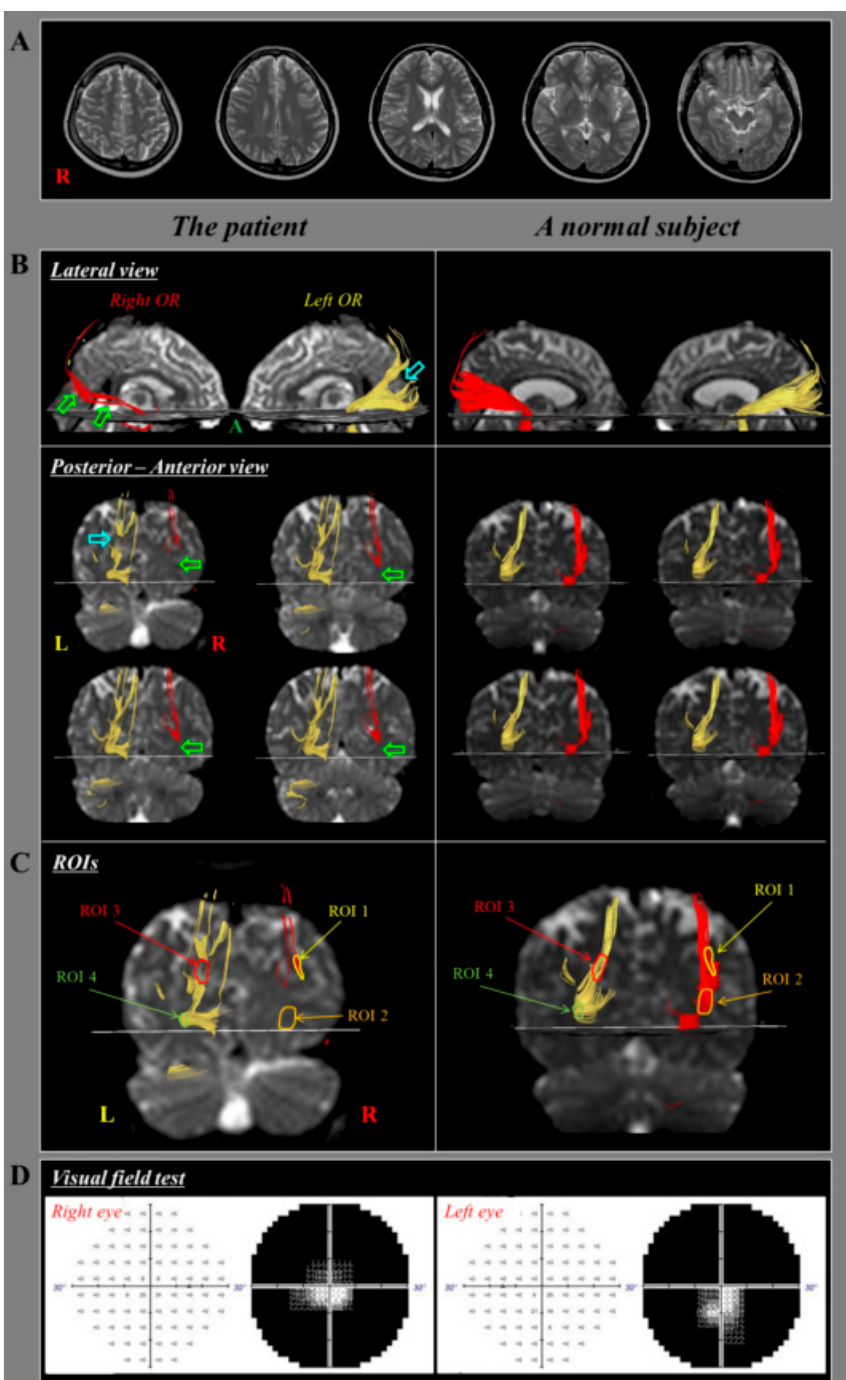
Figure 5. ( A ) Brain magnetic resonance images indicate no specific lesion; ( B ) Diffusion tensor tractography for the bilateral optic radiation (ORs) of the patient shows narrowing (green arrows) in the right OR and abrupt cut-off in the posterior portion (blue arrows) of the left OR compared with those in a control subject; ( C ) Four regions of interest (ROIs) in the ORs of the patient and a control subject are as follows: ROI 1, upper portion of the right OR; ROI 2, lower portion of the right ROI (narrowed area of the right OR in the patient); ROI 3, upper portion of the left OR (partially torn area of the left OR in the patient); and ROI 4, lower portion of the left ROI; ( D ) Humphrey visual field test result for the patient shows field defects in the peripheral area except for the central area of the whole visual field in both eyes (reprinted with permission